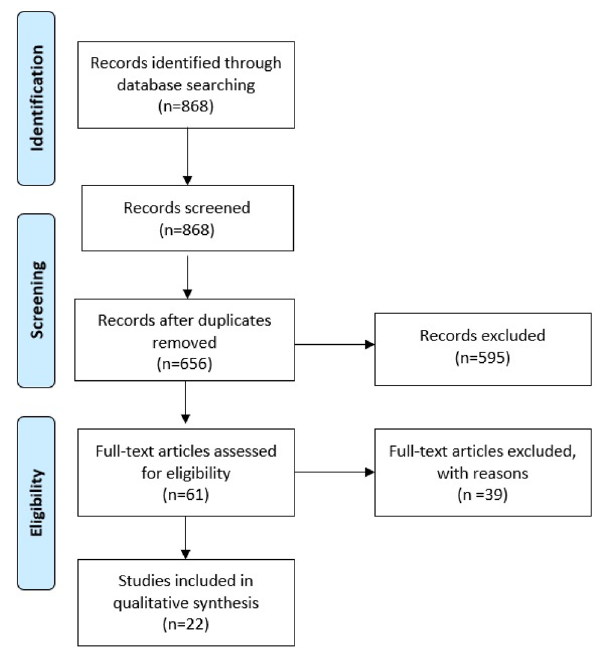
Fig. 1 Flow diagram of database